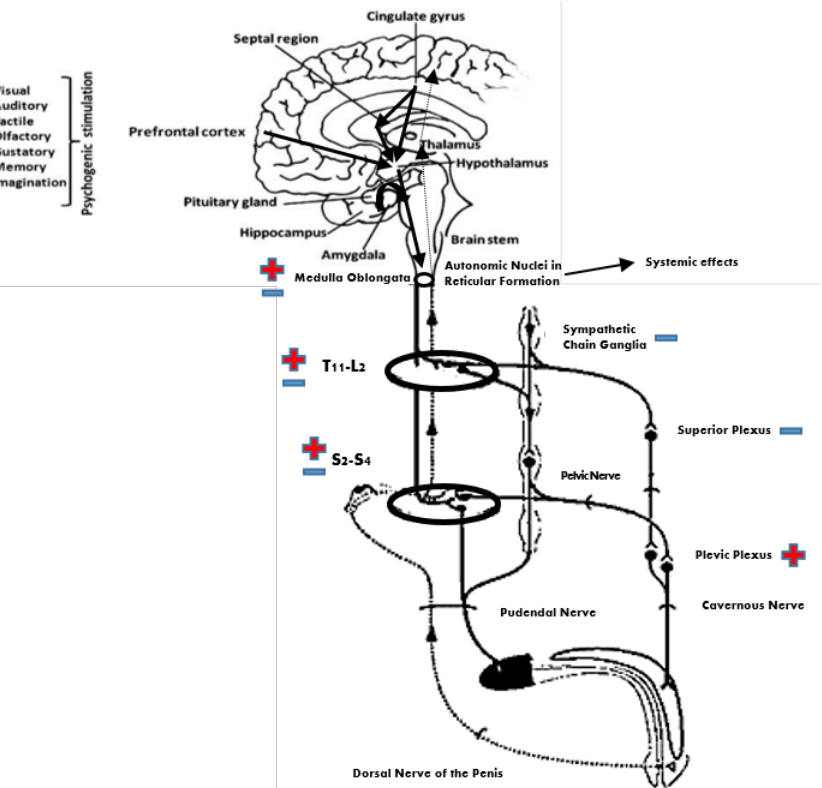
Figure 1. Diagram of the nervous pathways regulating erection. Reflexogenic erection depends on a circuitry made of the dorsal nerve of the penis / pudendal nerve, which conveys sensory input, a parasympathetic center in the sacral spinal cord, and the pelvic plexus / cavernous nerve, which convoys e ff erent output to the penis. Sensory input reaches the brain via ascending spinal pathways. The brain can initiate psychogenic erection by various stimuli received by or generated within the brain. It also controls lumbar sympathetic and sacral parasympathetic outflow to the penis. Overall, there is one penile tumescence pathway (lumbar and sacral spinal segment → pelvic plexus → cavernous nerve → penis) and three penile detumescence pathways (1: lumbar spinal segment → superior plexus → cavernous nerve → penis; 2: lumbar spinal segment → paravertebral sympathetic chain → pelvic / cavernous nerve → penis; 3: lumbar spinal segment → paravertebral sympathetic chain → pudendal nerve → penis). + and − indicate penile tumescence or detumescence e ff ect, respectively. SCI may cause structural changes within the pelvic floor, neuropathic pain, spasticity, and